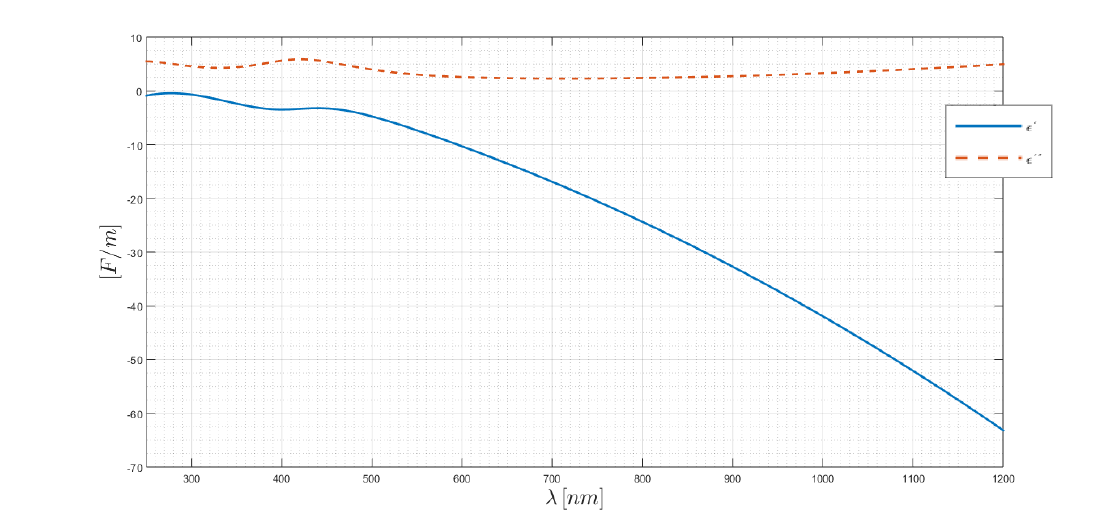
Figure A4. Copper complex dielectric function (solid blue line: real part; dashed red line: imaginary part).